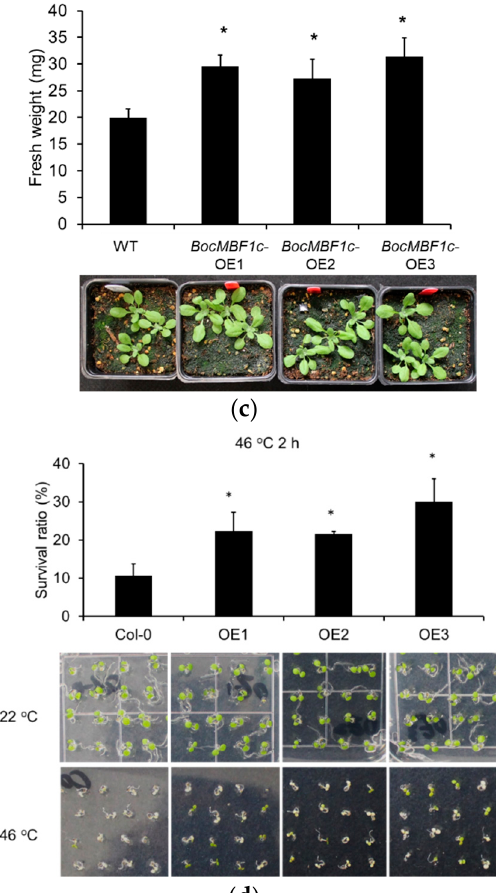
Figure 7. Phenotypic characterization of BocMBF1c-OE plants. ( a ) Schematic illustration of the 35s:: BocMBF1c-GUS construct used for ectopic expression. ( b ) Expression of BocMBF1c was validated by β -glucuronidase (GUS) staining ( n ≥ 15). ( c ) Compared with the wild type (WT) seedlings, the fresh weight of the BocMBF1c -OE plants indicated better growth, and the plants shown in the pictures were 14 days post-germination. Error bars represent the standard deviation of the means ( n = 20). ( d ) All three BocMBF1c -OE lines showed a higher survival ratio after heat stress than WT ( n = 100). Error bars are the mean ± SD of three independent experiments. Photos were taken 2 days after heat stress. Asterisk indicates statistical significance by the Student’s test ( p < 0.05).